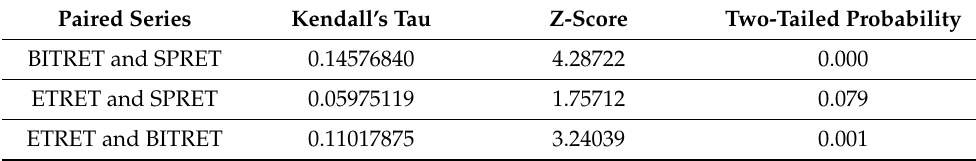
Table 7. Kendall’s tau measure of association between the the return series in Period